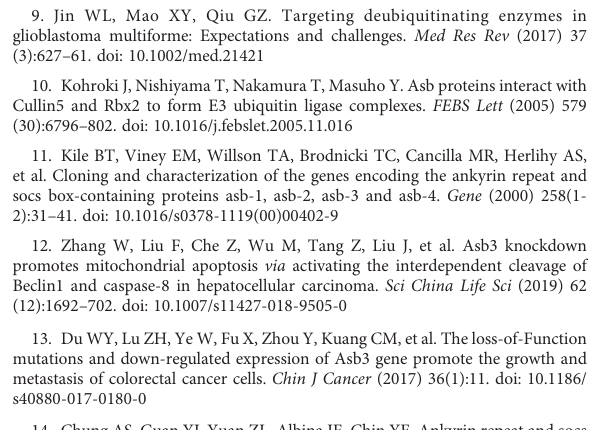
SUPPLEMENTARY FIGURE 1 The correlation of ASB3 expression and TMB or MSI in pan-cancer. (A) Correlation coef fi cient between ASB3 expression and TMB, positively in 5 cancer types and negatively in 3 cancer types. (B) Correlation coef fi cient between ASB3 expression and MSI, positively in 7 cancer types and negatively in 5 cancer types. * P < 0.05, ** P < 0.01, *** P < 0.001.